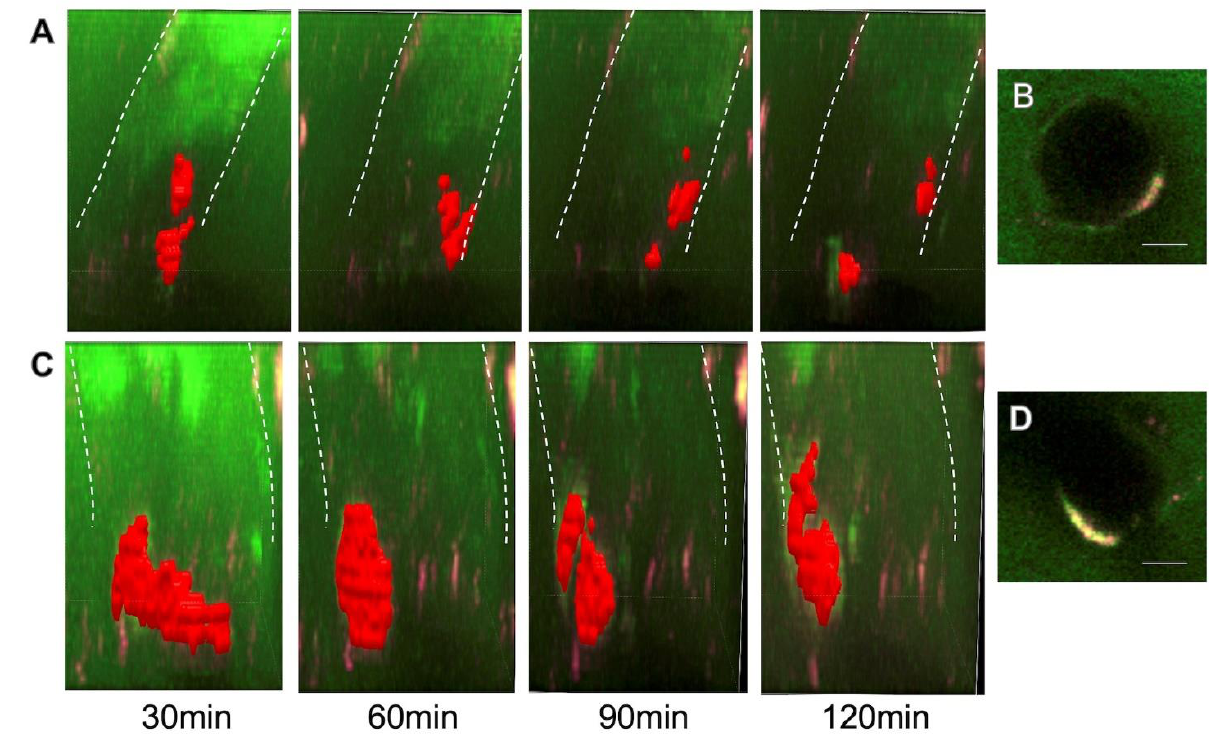
Figure 3. Dynamic perivascular transportation of HiLyte Fluor 647-labeled A β 1–40 oligomers ( A , B ) and fibrils ( C , D ). The perivascular distribution of A β was captured in horizontal planes ( B , D ) and reconstructed in 3 dimensions every 30 min ( A , C ). FITC-labeled dextran at 40 kD was distributed in the entire circumference of penetrating vessels, whereas A β accumulated in only localized perivascular spaces ( B , D ). The accumulated mass of A β oligomers moved around the vessel wall and separated ( A ). A β fibrils formed a large mass and elongated in the direction of a penetrating vessel ( C ). Scale bar: ( B , D ) 10 µ m. Three-dimensional images and dynamic motion are shown in Supplementary Videos.